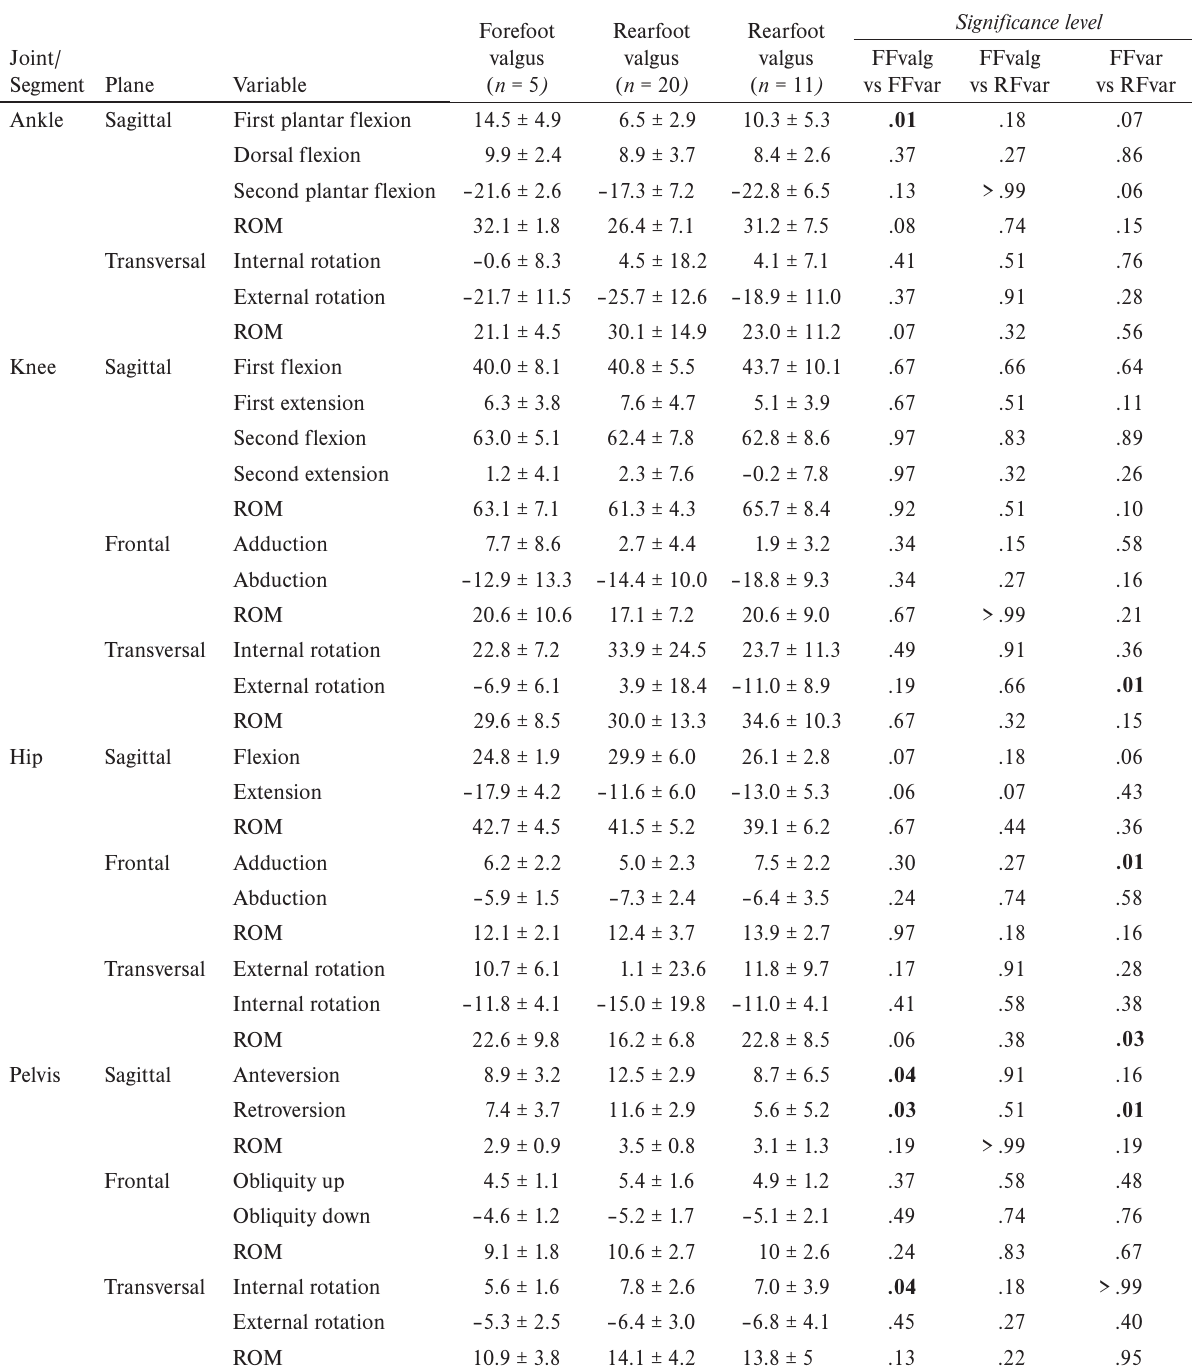
Table 1 Kinematic gait parameters (peak values and range of motion, given in degrees) of lower limb joints and pelvis and their differences between functional clinical foot types